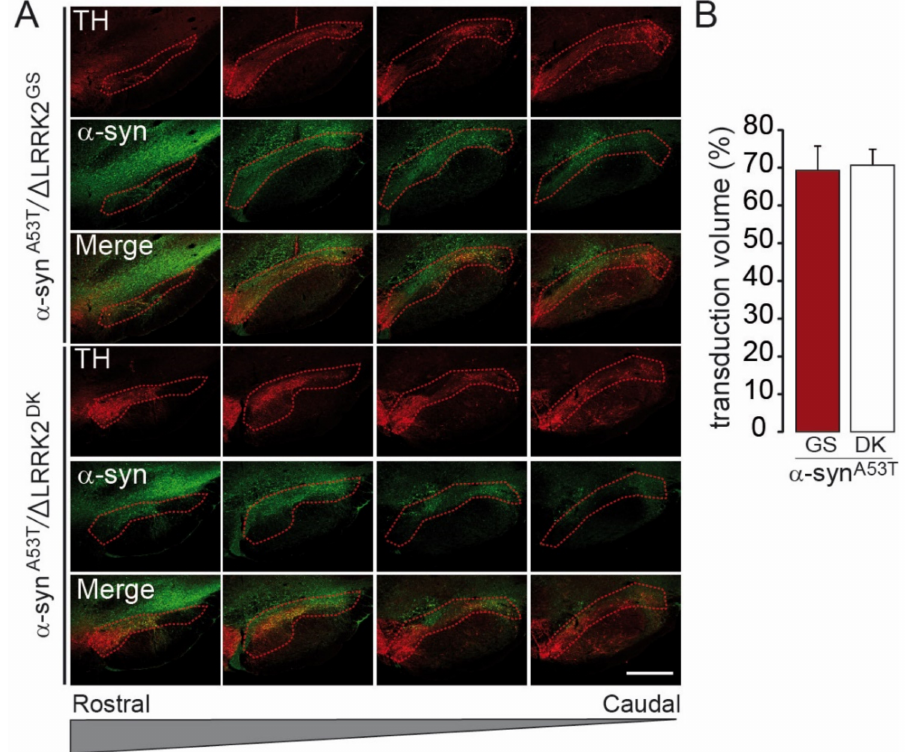
Figure 7. Measurement of the SNpc volume transduced by AAV- ∆ LRRK2 G2019S and the dead kinase form ∆ LRRK2 G2019S/D1994A . ( A ) Confocal images to delineate the SNpc based on TH staining (in red), reported in the green channel, corresponding to the α -syn immunofluorescence when co-expressed with ∆ LRRK2 G2019S ( ∆ LRRK2 GS ) or ∆ LRRK2 DK , the dead kinase form ∆ LRRK2 G2019S/D1994A . Scale bar: 1000 µ m. ( B ) Quantification of the fraction (%) of the SNpc expressing α -syn protein af- ter co-transduction with ∆ LRRK2 G2019S or ∆ LRRK2 G2019S/D1994A . Results are expressed as the means ± SEM. N = 8 animals/group. No statistical difference, Student’s t